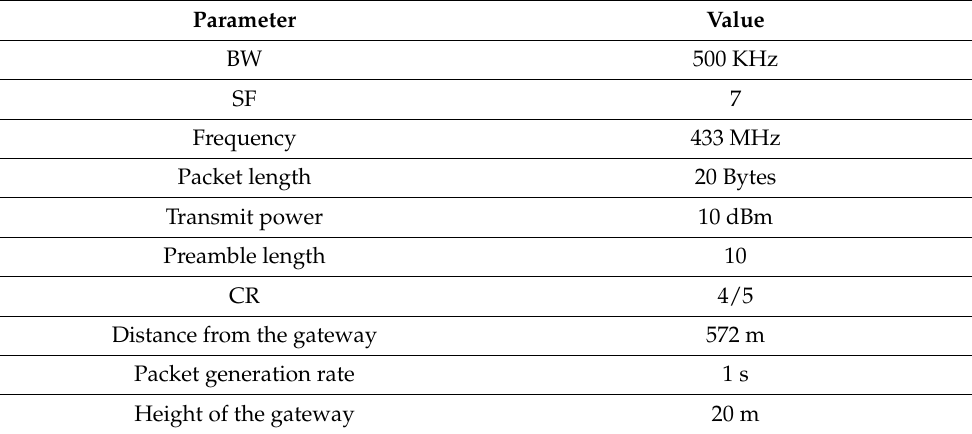
Figure 12. Experimental scenario 1.